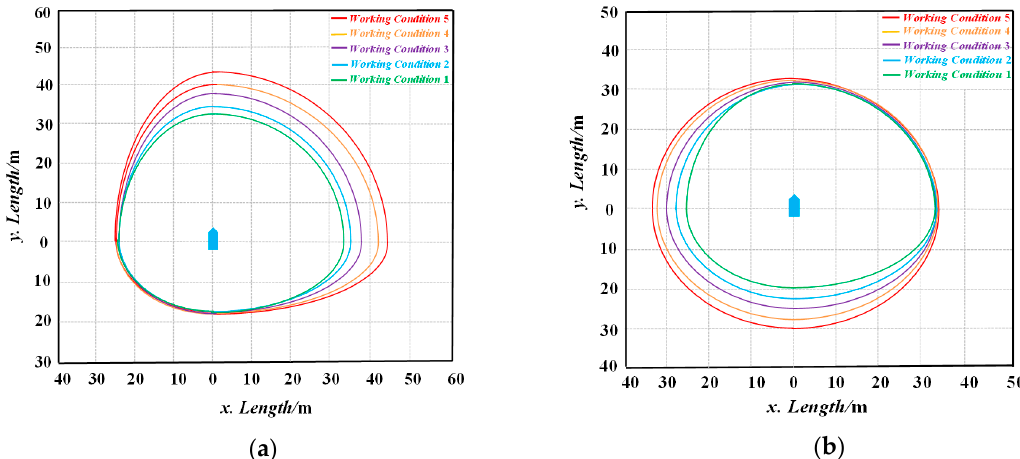
Figure 12. Radius changes of the DNSD in the overtaking situation: ( a ) Under the first angle groups; ( b ) Under the second angle groups.